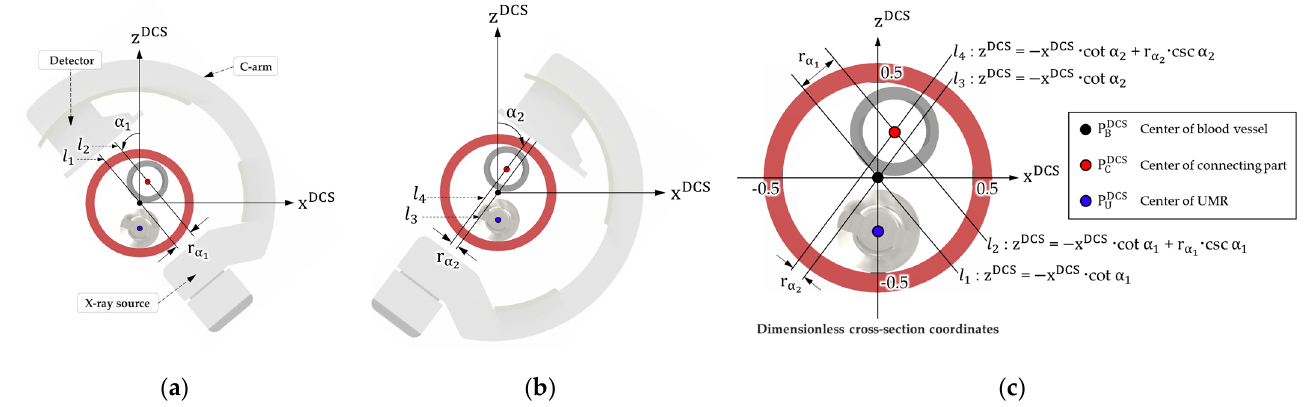
Figure 4. ( a ) Representation of r α 1 in the cross-section of the blood vessel when the oblique angle is α 1 ; ( b ) representation of r α 2 in the cross-section of the blood vessel when the oblique angle is α 2 ; ( c ) DCSs with the vessel center P (cid:2886)(cid:2888)(cid:2887)(cid:2903) , the center of the delivery catheter’s connecting part P (cid:2887)(cid:2888)(cid:2887)(cid:2903) , and the UMR’s center P (cid:2905)(cid:2888)(cid:2887)(cid:2903) .